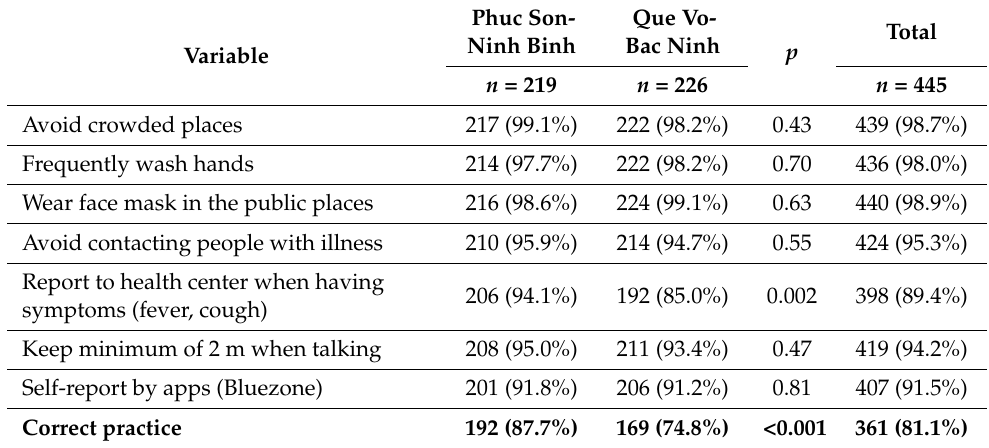
Table 2. Migrant worker’s practices on COVID-19 prevention and